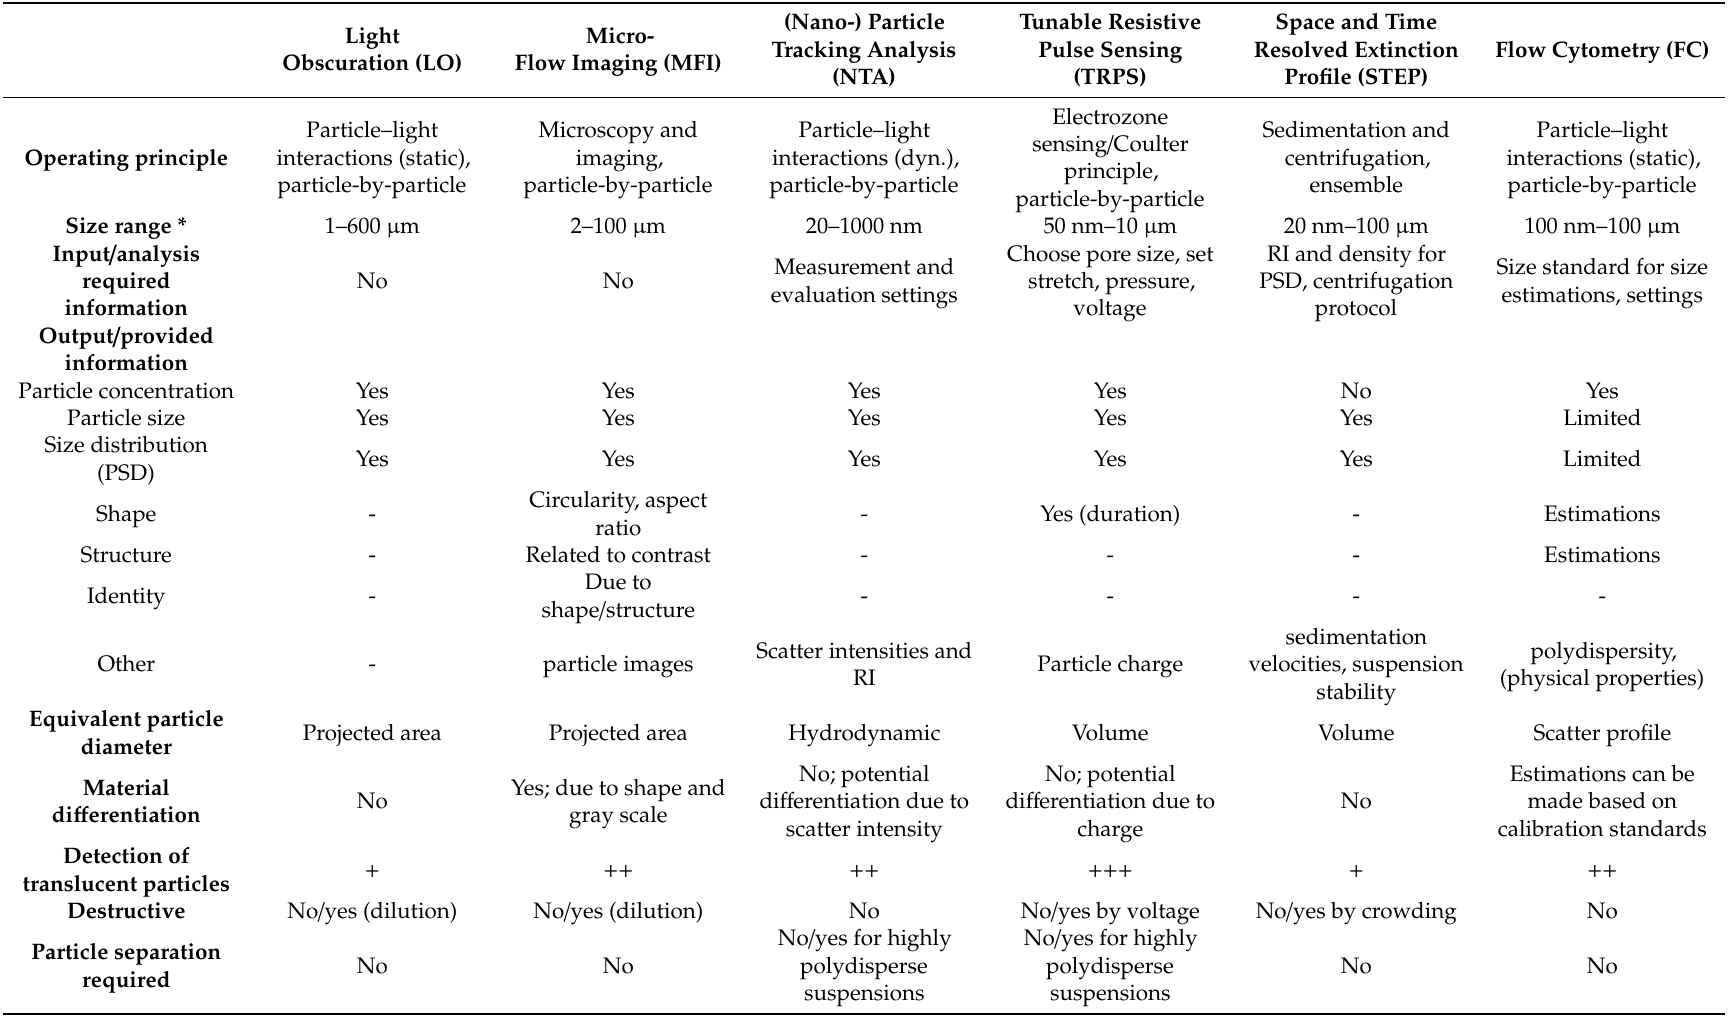
Table 2. Examples of current principles of established and alternative techniques for biopharmaceuticals in comparison to light